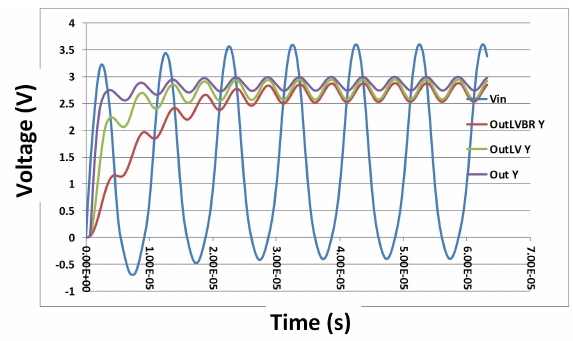
Figure 5: Transient and steady-state load voltage of CMOS rectifiers with normal and low-V th transistor with and without bulk regulation.